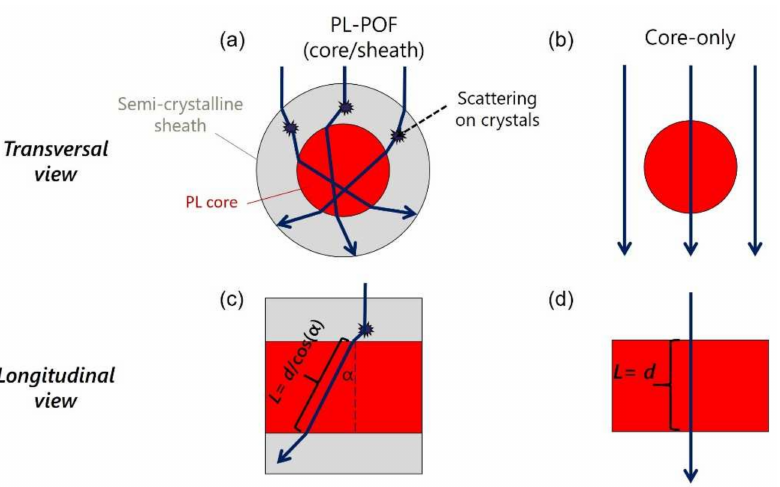
Figure 6. Schematic explanation of the effect of scattering in a semi-crystalline sheath onto axial light emission. The transversal transmission of light through a core/sheath PL-POF is shown in ( a ) and through a core-only fiber in ( b ). Corresponding longitudinal views are shown in ( c , d ). In summary, scattering in the sheath leads to prolonged optical pathways across the photoluminescent core, thus increasing the probability for light down-conversion with axial